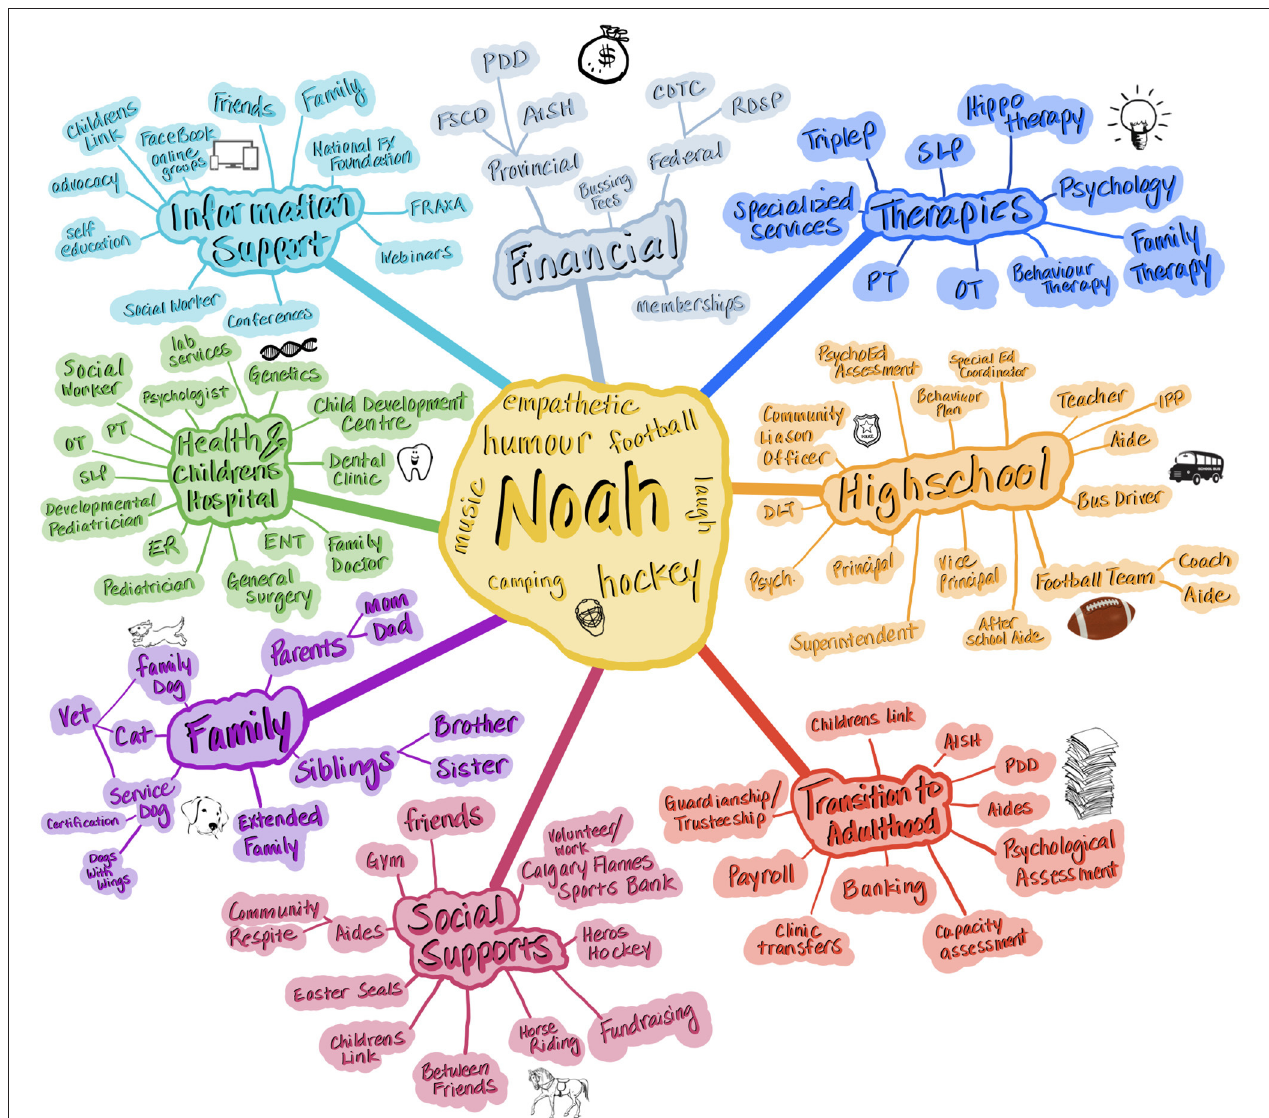
FIGURE 2 | Care maps help to display the multiple entities related to individuals with FXS. A care map captures the multidimensional aspect of care needs and is organized around a given individual. Use of pictures, colors, and shapes can help to involve youth in the development of the care map while identifying priorities over time. Care maps are often color coded to provide visual distinction between fields. Note that overlap between providers becomes more apparent and allows for collaboration. For instance, occupational therapy could be provided in school and community. Legend of terms used in the figure: PDD, Persons With Developmental Disabilities (Provincial funding program in Canada); FSCD, Family Support for Children with Disabilities (Provincial funding program in Canada); AISH, Assured Income for the Severely Handicapped (Provincial funding program in Canada); CDTC, Child Disability Tax Credit (Federal funding program in Canada); RDSP, Registered Disability Savings Plan; SLP, Speech Language Pathologist; PT, Physical Therapy; OT, Occupational Therapy; ER, Emergency Room; ENT, Ear, Nose, and Throat Specialist; IPP, Individual Performance Plan; DLT, Diverse Learning